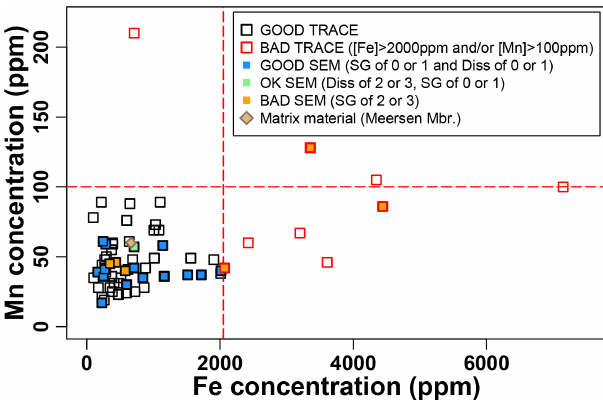
Figure 4. Iron and manganese concentrations of all samples used for diagenesis screening. Samples with Fe concentrations above 2500ppm or Mn concentrations above 100ppm (or both) were not considered for further interpretation. These thresholds were cho- sen based on prior studies (see text), then adjusted to lower, more conservative levels to screen out most samples showing secondary growth while keeping all samples showing good preservation or solely dissolution under SEM (see Fig.